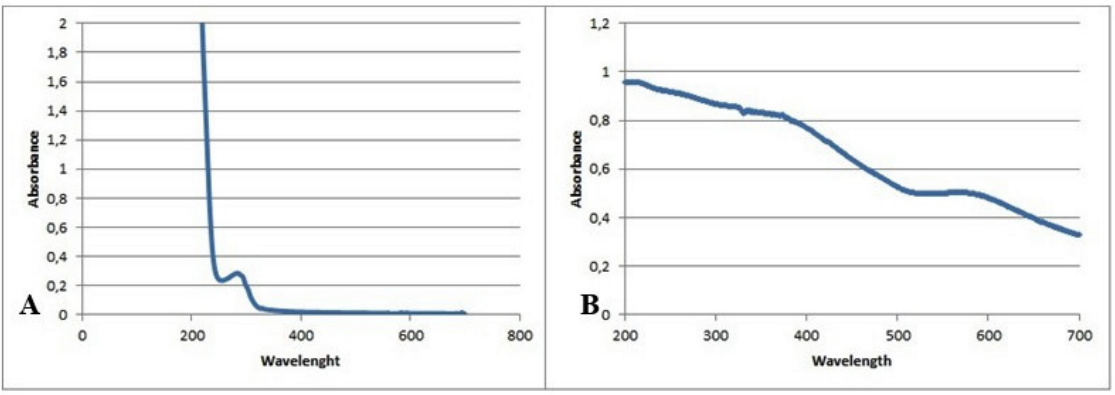
O particles after magnetic separation, C. Gold coated Fe 3 4 O particles after magnetic separation and separated gold 3 4